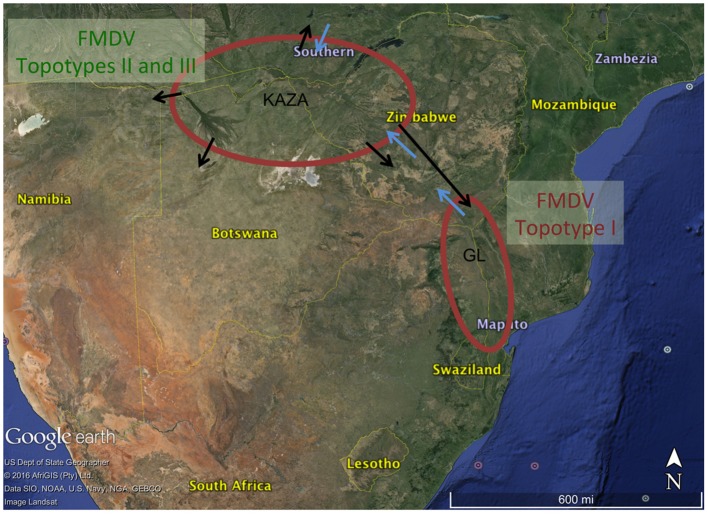
Significant transmission between countries and TFCAs: Kavango–Zambezi (KAZA) and Great Limpopo (GL) TFCAs areas are indicated with a red circle. Arrows represent significant transmission (BF > 3) as detected by BSSVS.